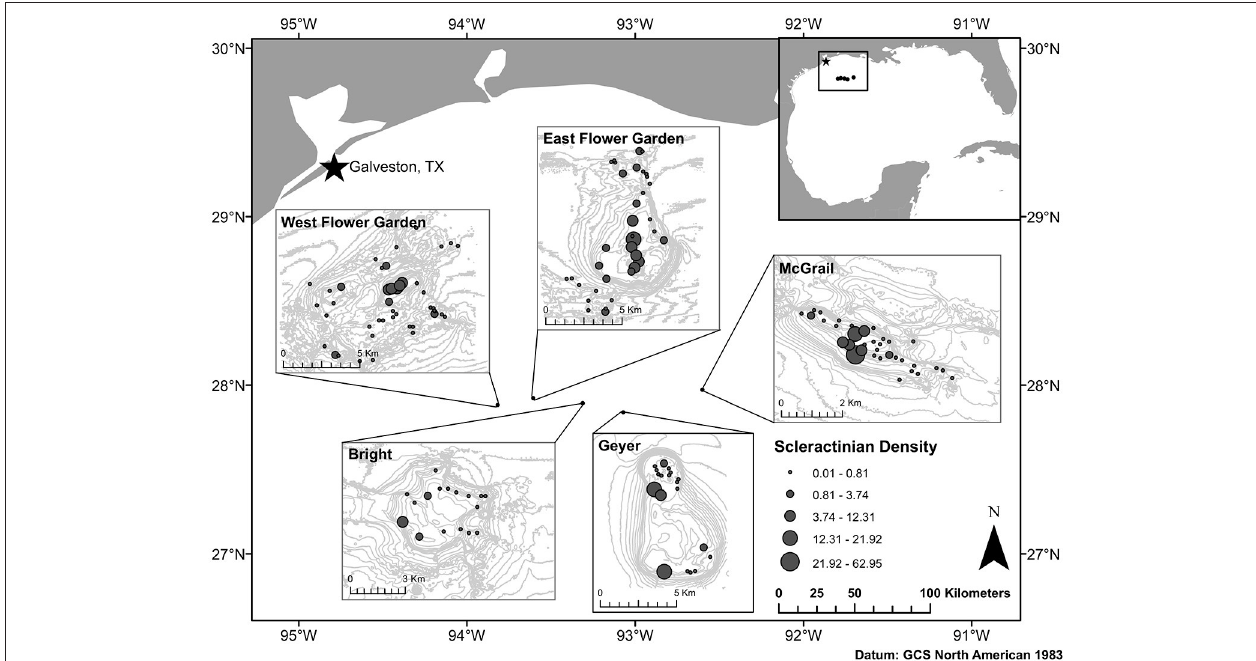
FIGURE 1 | Map of the northwest Gulf of Mexico showing the locations of five reef banks and the density of scleractinian (number of colonies by m 2 ) for each bank. Banks from west to east: West Flower Garden, East Flower Garden, Bright, Geyer, and Mc Grail. The inset map shows the location of the five banks in the entire Gulf of